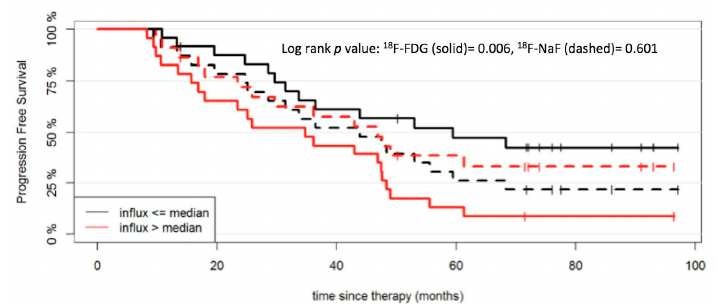
Figure 4. PFS outcome after start of therapy according to influx derived from reference tissue for 18 F ‐ NaF and 18 F ‐ FDG PET/CT. The patient cohort is dichotomized at the median influx values for 18 F ‐ NaF (0.07 mL min − 1 mL − 1 ) and 18 F ‐ FDG (0.01 mL min − 1 mL − 1 ).